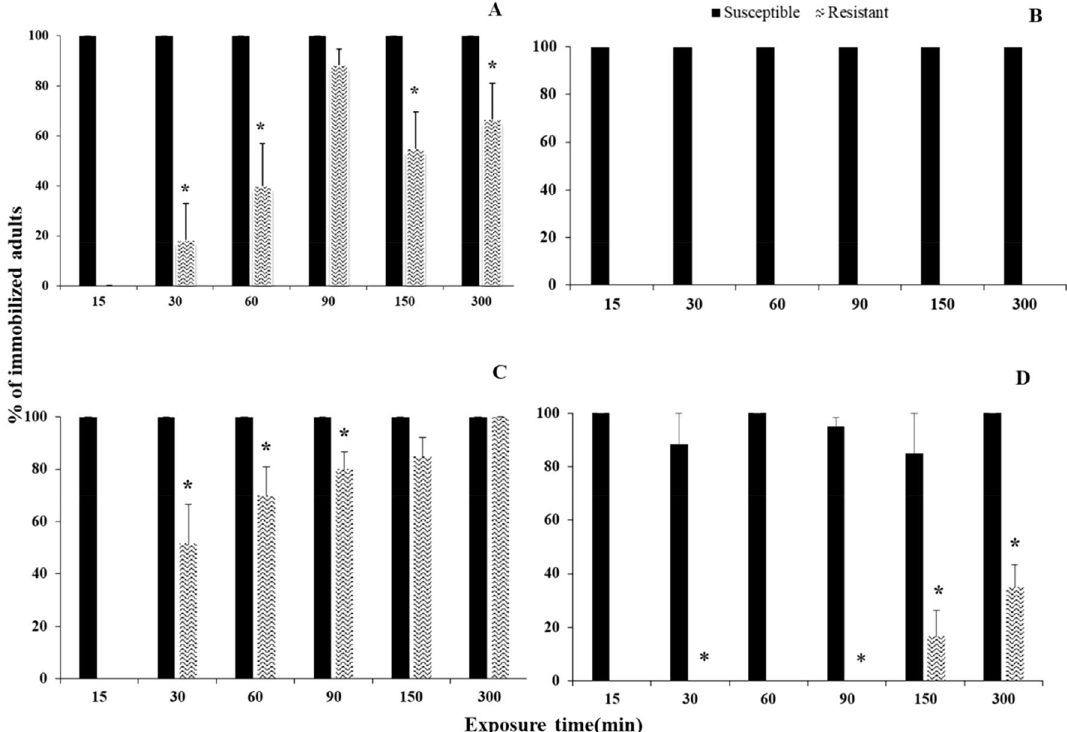
Figure 1. Percentage (% ± SE) of immobilized adults of two populations (phosphine-susceptible and -resistant) of R. dominica ( A ), S. oryzae ( B ), O. surinamensis ( C ) and T. castaneum ( D ), after different exposure times to phosphine at 3000 ppm (in min). Means with asterisks indicated differences between susceptible and resistant populations according to Student’s t -test, at n-2 degrees of freedom and at 0.05. According to t -test, the parameters for each exposure interval were: for R. dominica at 30 min t = 5.5, P < 0.01, at 60 min t = 3.5, P < 0.01, at 150 min t = 3.0, P < 0.01, at 300 min t = 2.2, P < 0.01, for O. surinamensis at 30 min t = 3.2, P < 0.01, at 60 min t = 2.7, P < 0.01, at 90 min t = 2.9, P < 0.01, for T. castaneum at 30 min t = 7.5, P < 0.01, at 90 min t = 27.8, P < 0.01, at 150 min t = 3.8, P < 0.01, at 300 min t = 7.6, P < 0.01. In all cases, df value was